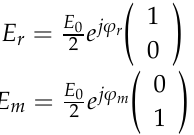
Figure1showsthe opticalconfigurationofa compactdesignof